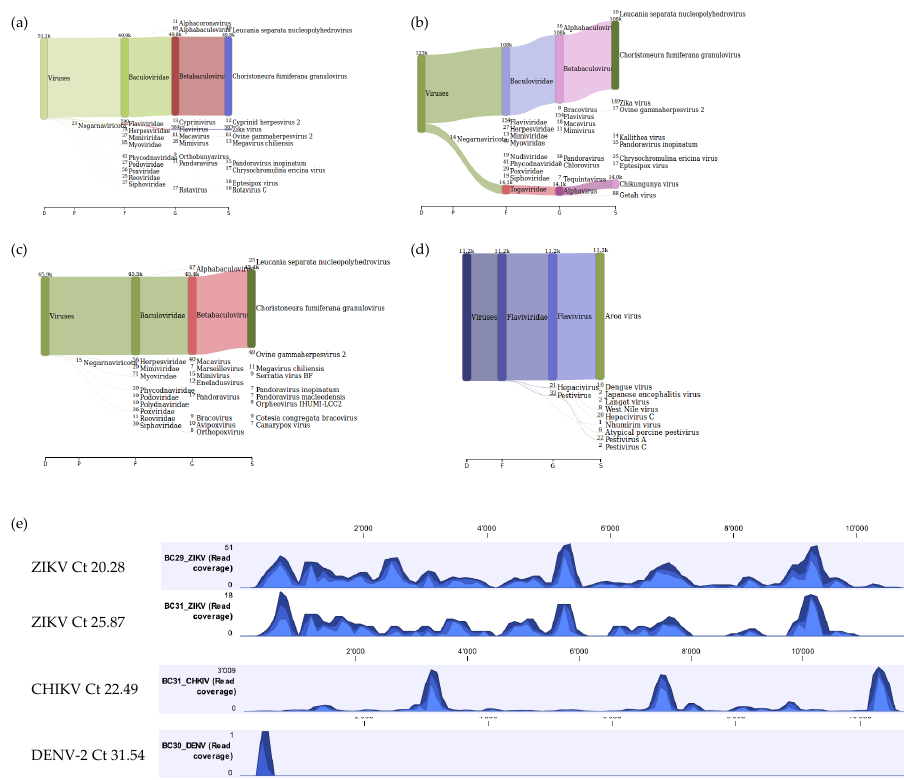
Figure 6. Sankey diagrams of Kraken 2 report results obtained for mosquito homogenates positive for ZIKV (panel a ), ZIKV and CHIKV (panel b ), and DENV-2 (panel c ). Panel ( d ) represents results of DENV-2 using a custom database for flaviviruses only. Panel ( e ) demonstrates the coverage track profile of ZIKV, CHIKV, and DENV-2 samples extracted using the developed Method 5. Ion S5 reads for ZIKV were mapped on to the ZIKV reference genome (NC_012532.1), CHIKV mapped on to the CHIKV reference genome (NC_004162.2), and DENV-2 mapped onto the reference genome (NC_001474.2). Average coverage values are indicated for each sample on the